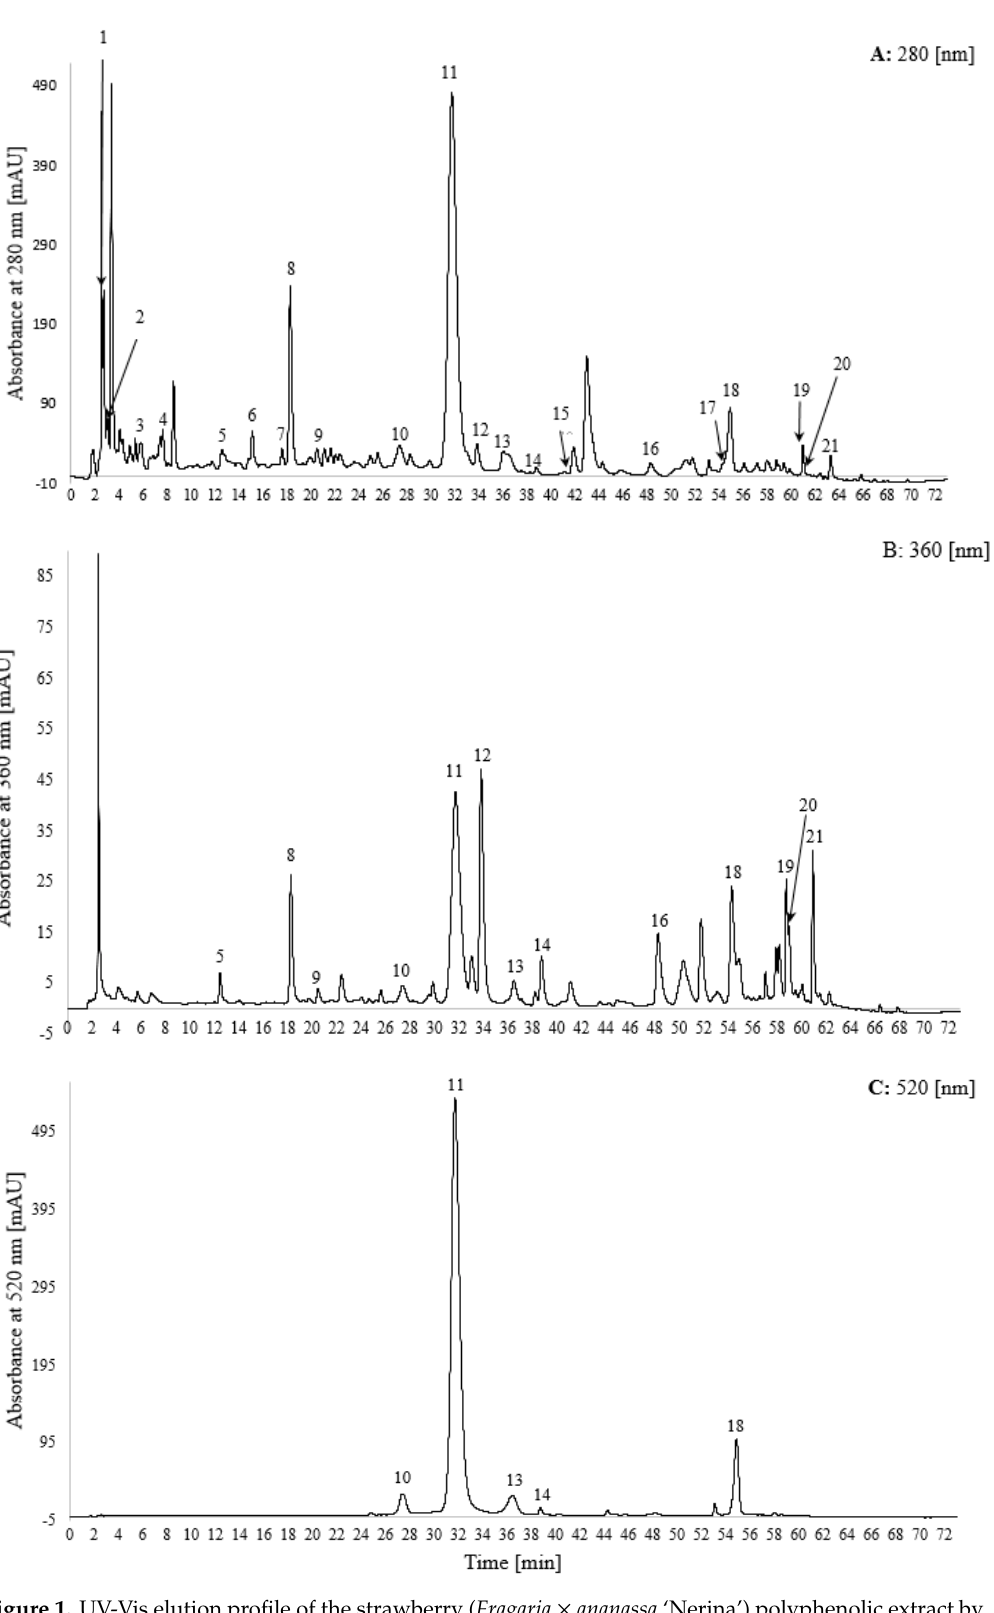
Figure 1. UV-Vis elution profile of the strawberry ( Fragaria × ananassa ‘Nerina’) polyphenolic extract by HPLC in 3 wavelengths ( A —280 nm, B —360 nm and C —520 nm).